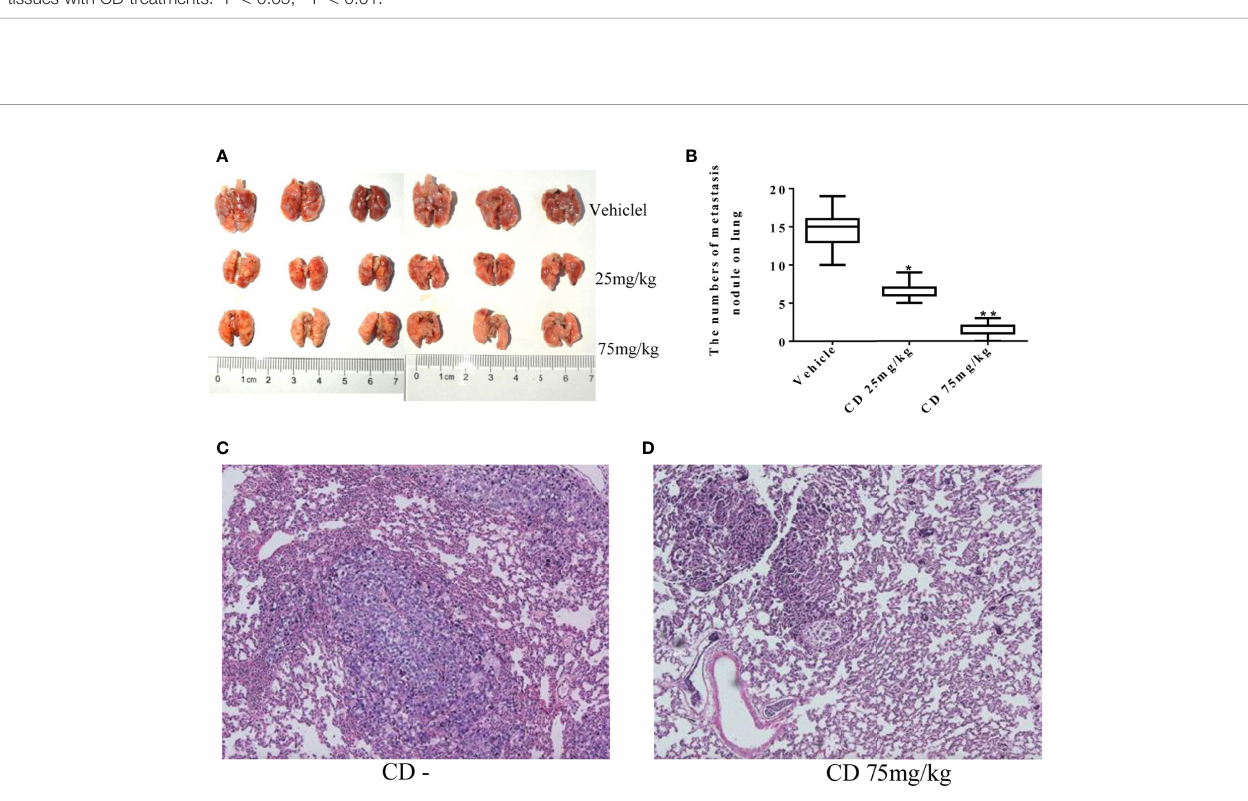
FIGURE 5 | Cordycepin treatment inhibits tumor growth in breast cancer model of mouse. (A, B) CD treatment inhibited the tumor growth in mice. Quantitative data are shown in the right panel of (B) . (C) H&E staining image results of in situ tumor tissues without CD treatments. (D) H&E staining image results of in situ tumor tissues with CD treatments. *P < 0.05, **P <